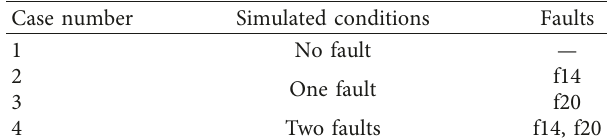
Figure 3: The 3D finite difference model of the rock slope with two faults. Table 3: Mechanical properties of the rock